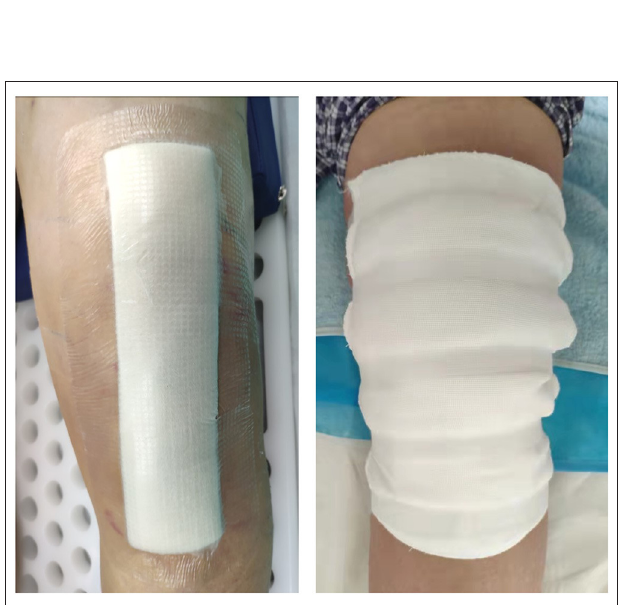
FIGURE 2 | The appearances of wound dressings (left: new dressing system; right: traditional gauze dressing).